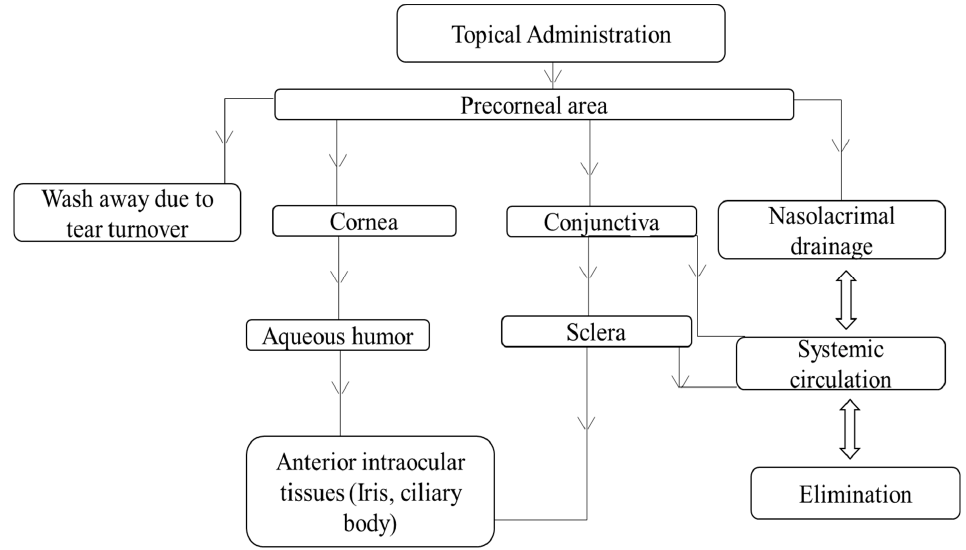
Figure 10. Possible disposition routes of nanocarriers following topical administration.